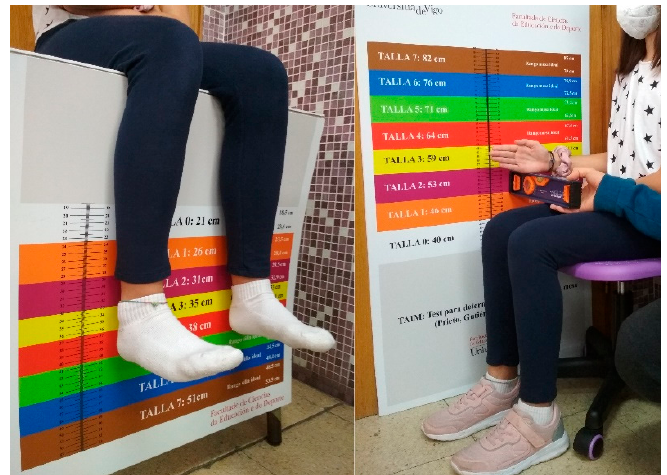
Figure 2. Use of measuring tool ISHT and IDHT.